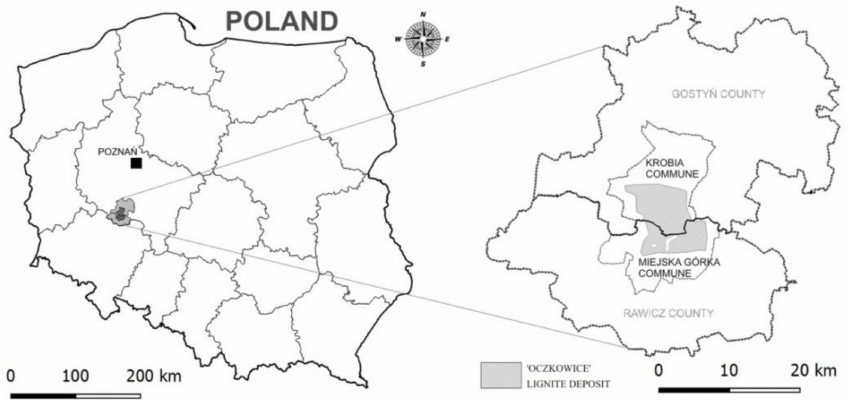
Figure 2. Location of the case